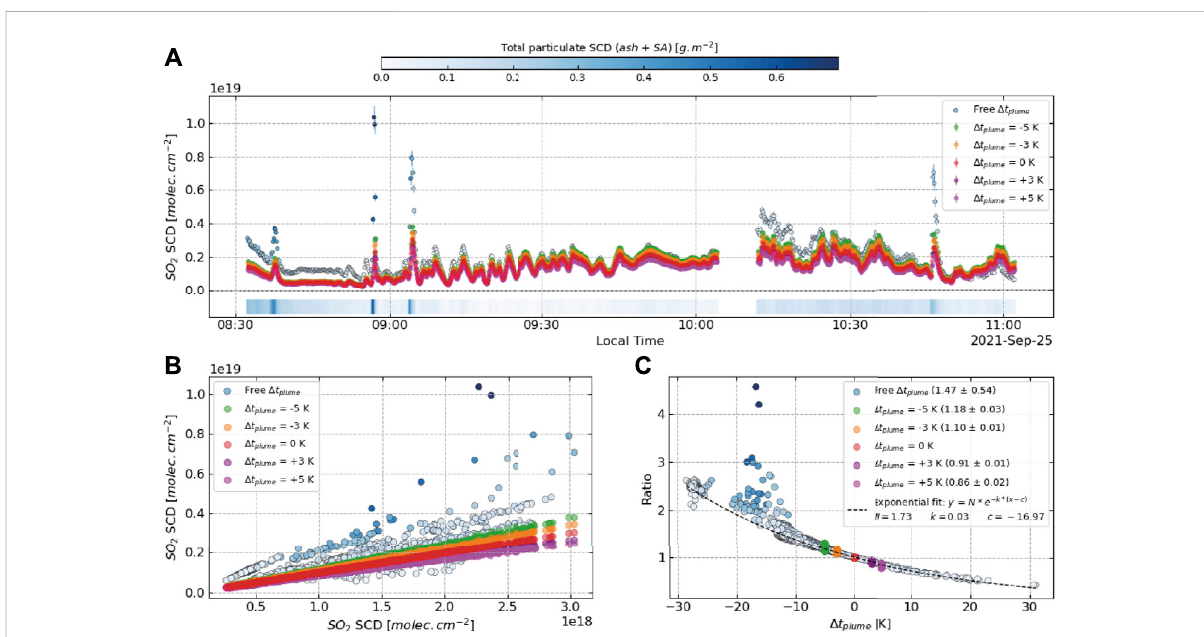
FIGURE 11 Sensitivity analysis of the effect of plume temperature on the retrieved SO 2 SCDs. (A) Time series of SO 2 SCDs for a subset of 1,000 spectra measured on 25 September 2021, using various values of Δ t plume (green: − 5 K; orange: − 3 K; red: 0 K; purple: +3 K; magenta: +5 K; blue: free parameter). Bar plot at the bottom shows the total SCD for all particulate species (colour scale at the top), highlighting the eruptive events with high ash or sulphate aerosols (SA). Data points in the free T plume retrieval are also coloured according to the total particulate SCD (B) Retrieved SO 2 SCDs for each of the time series mentioned above against the corresponding SO 2 SCD in the reference retrieval ( Δ t plume = 0 K). Note that measurements with high amounts of particulates produce larger overestimates in the retrieved SO 2 (C) Ratio between retrieved SO 2 in each time